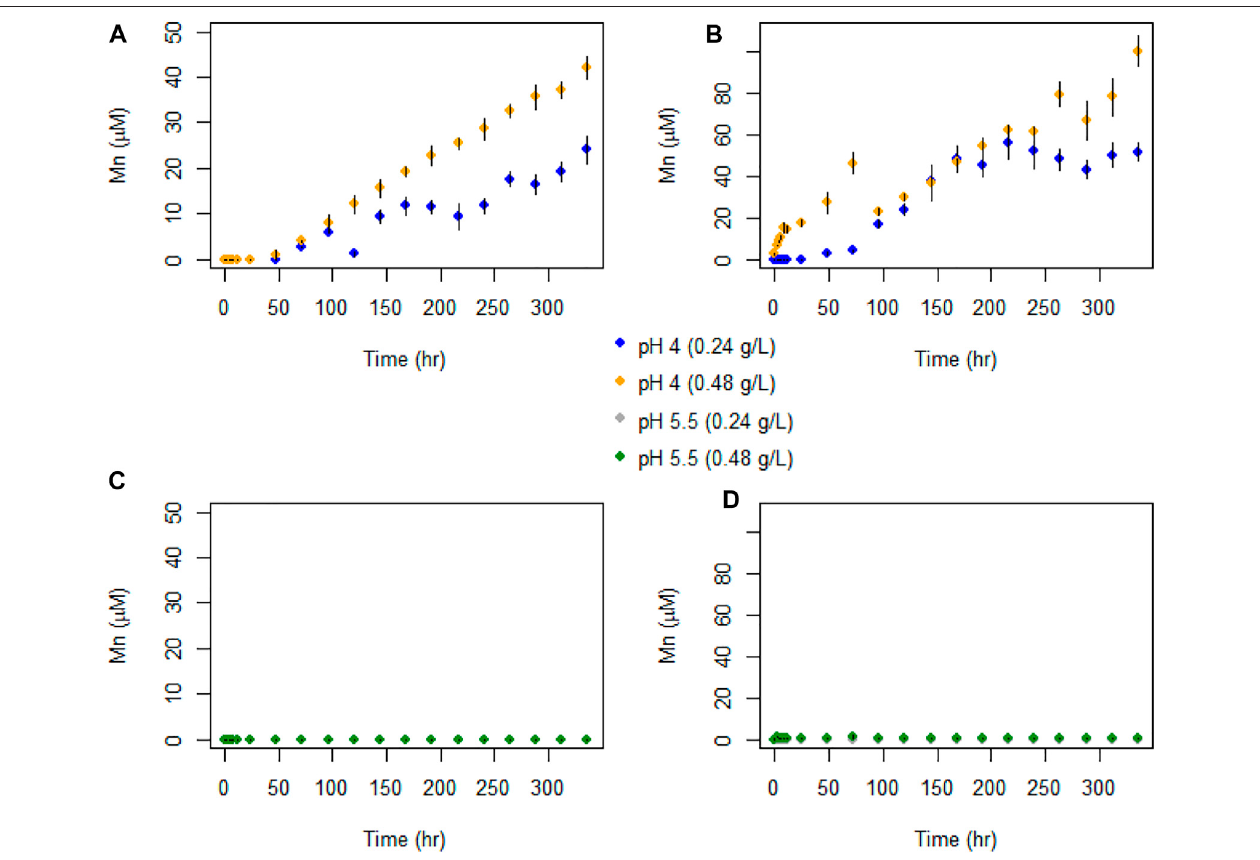
FIGURE7| TemporalevolutionofMn(II)concentrationsinbatchexperimentswith (A) ARbirnessiteatpH4, (B) SGbirnessiteatpH4), (C) ARbirnessiteatpH5.5,and (D) SG birnessite at pH 5.5. All experiments were performed at 25 ° C with an initial Se(IV) of 120 μ M. Error bars represent SDs for concentrations measured in duplicates.